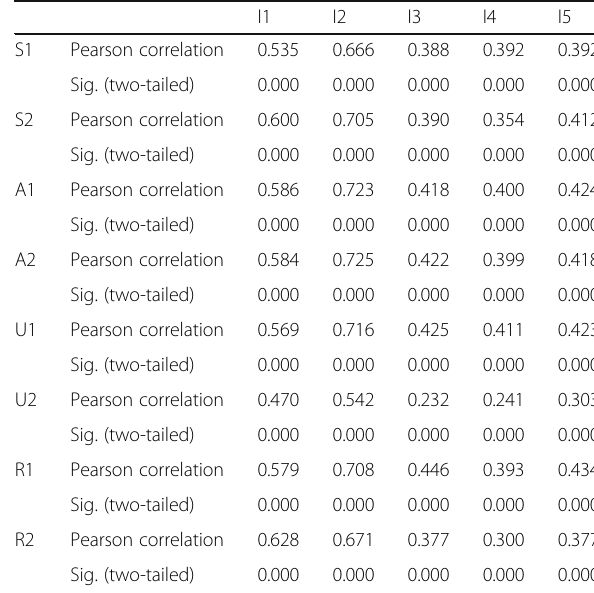
Table 2 The correlation test between inputs and outputs of the